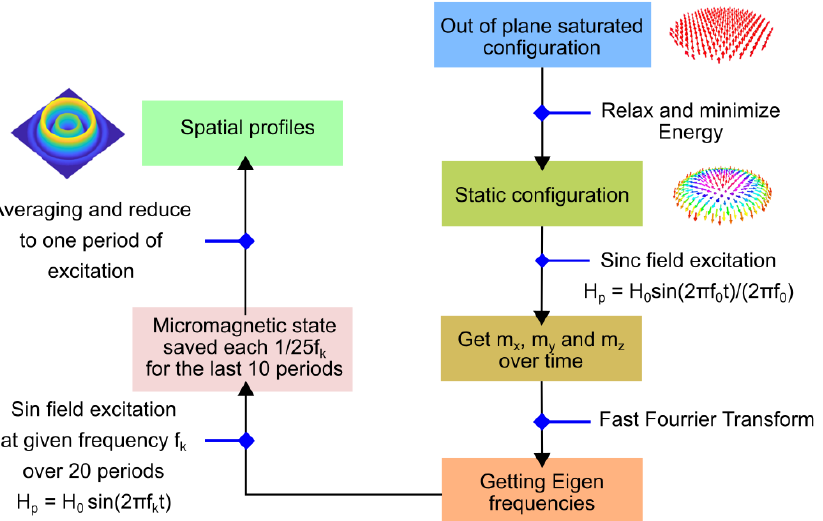
Figure 2. Scheme showing the different steps (1–11) used to obtain the spatial mode